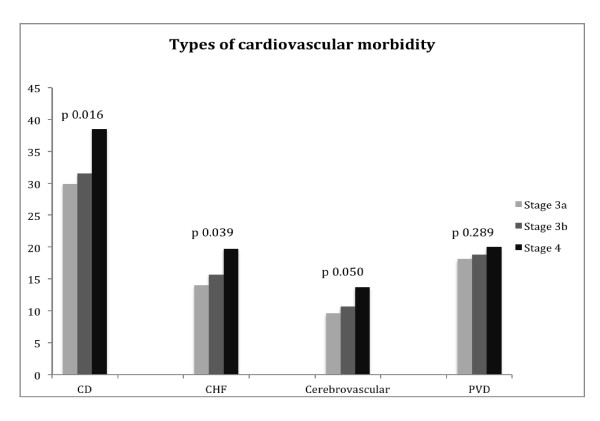
Summary of cardiovascular morbidity types based on staging of CKD (stages 3a, 3b, 4). A significant increase in cardiac disease (CD), congestive heart failure (CHF) and cerebrovascular disease is seen. The increase in Peripheral vascular disease ( PVD) was not statistically significant.